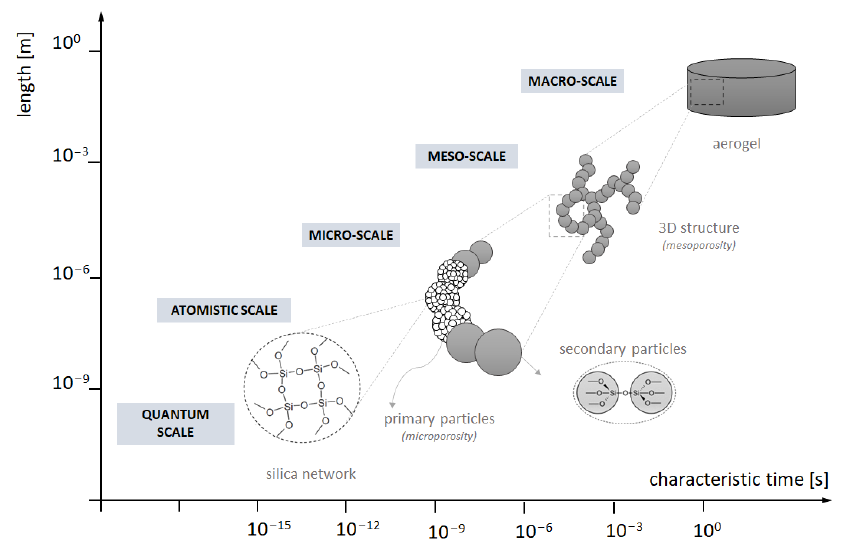
Figure 1. Compilation of hierarchic structure levels and scales in terms of numerical modelling.